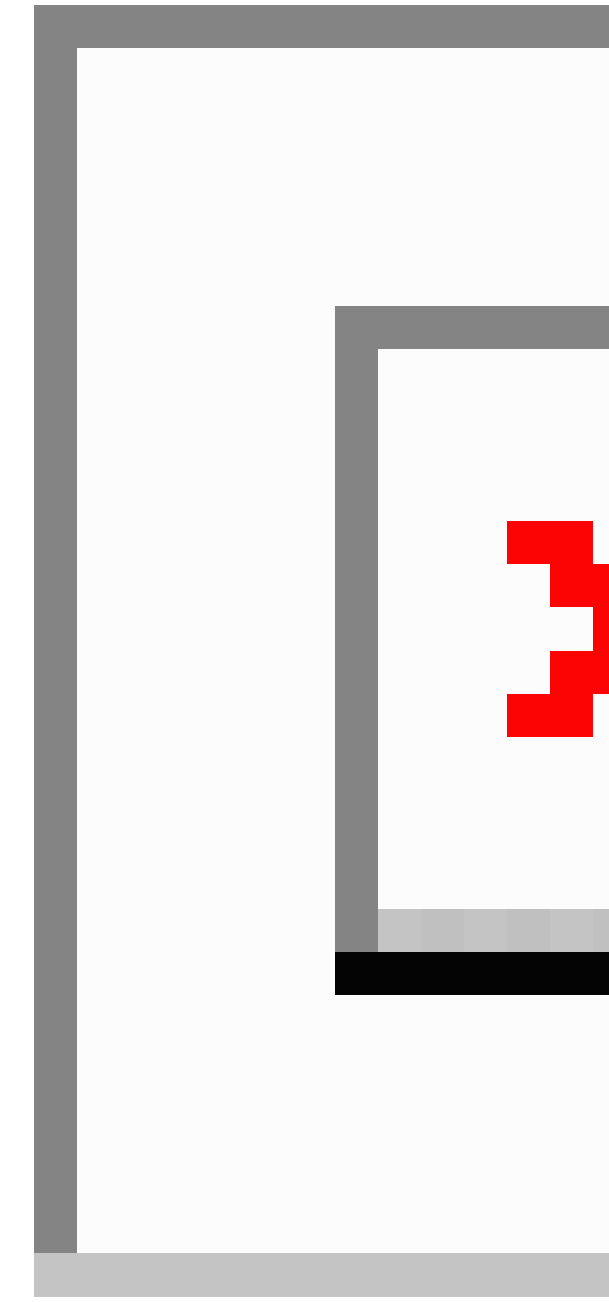
Figure 3. Equation for marginal treatment total.